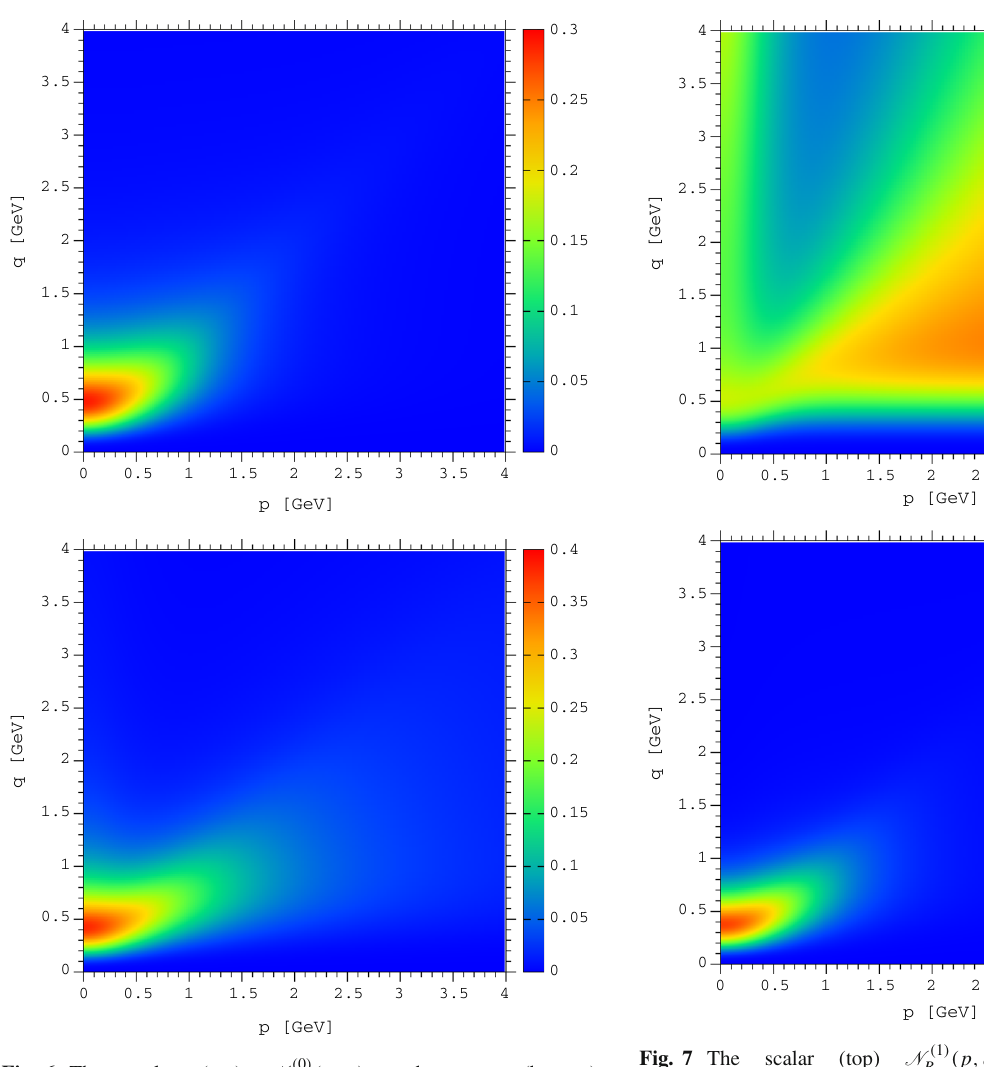
Fig. 6 The scalar (top) N ( 0 ) ( p , q )/ p 2 kernelcomponents oftheDyson–Schwinger equations. N ( 0 ) A